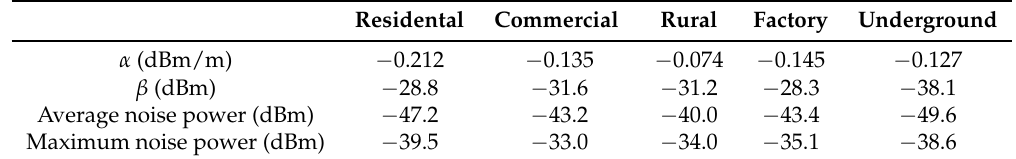
Table 2. Summary of the regression model coefficients for PLC signal and noise powers at various areas. Residental Commercial Rural Factory Underground α (dBm/m) − 0.212 − 0.135 − 0.074 − 0.145 −